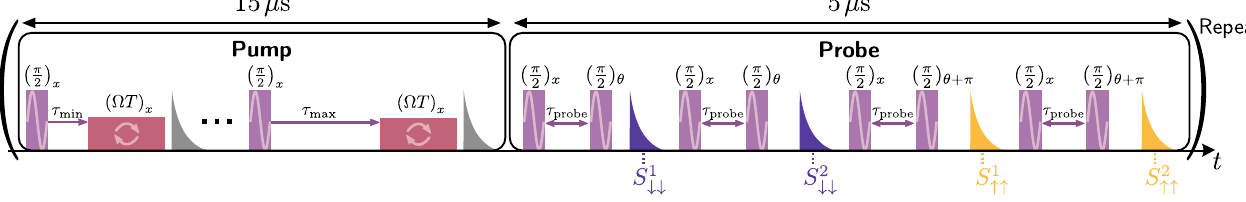
ω via θ ¼ 2 πτ serr probe serr